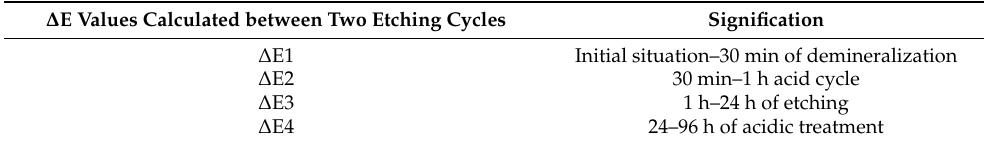
Table 2. ∆ E values and their signification. ∆ E Values Calculated between Two Etching